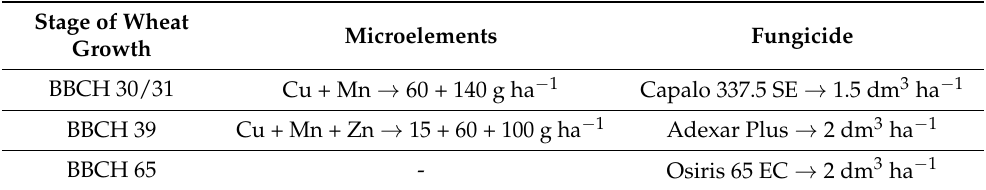
Table 3. Time schedule and composition of micronutrients and fungicides applied to wheat. Stage of Wheat